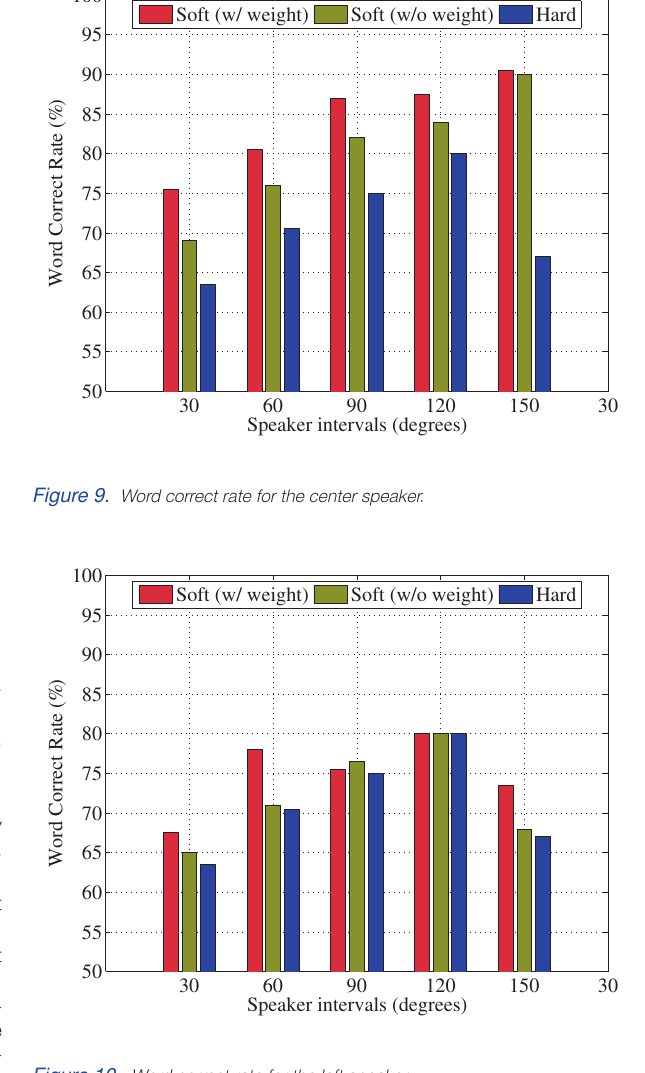
Figure 10. Word correct rate for the left